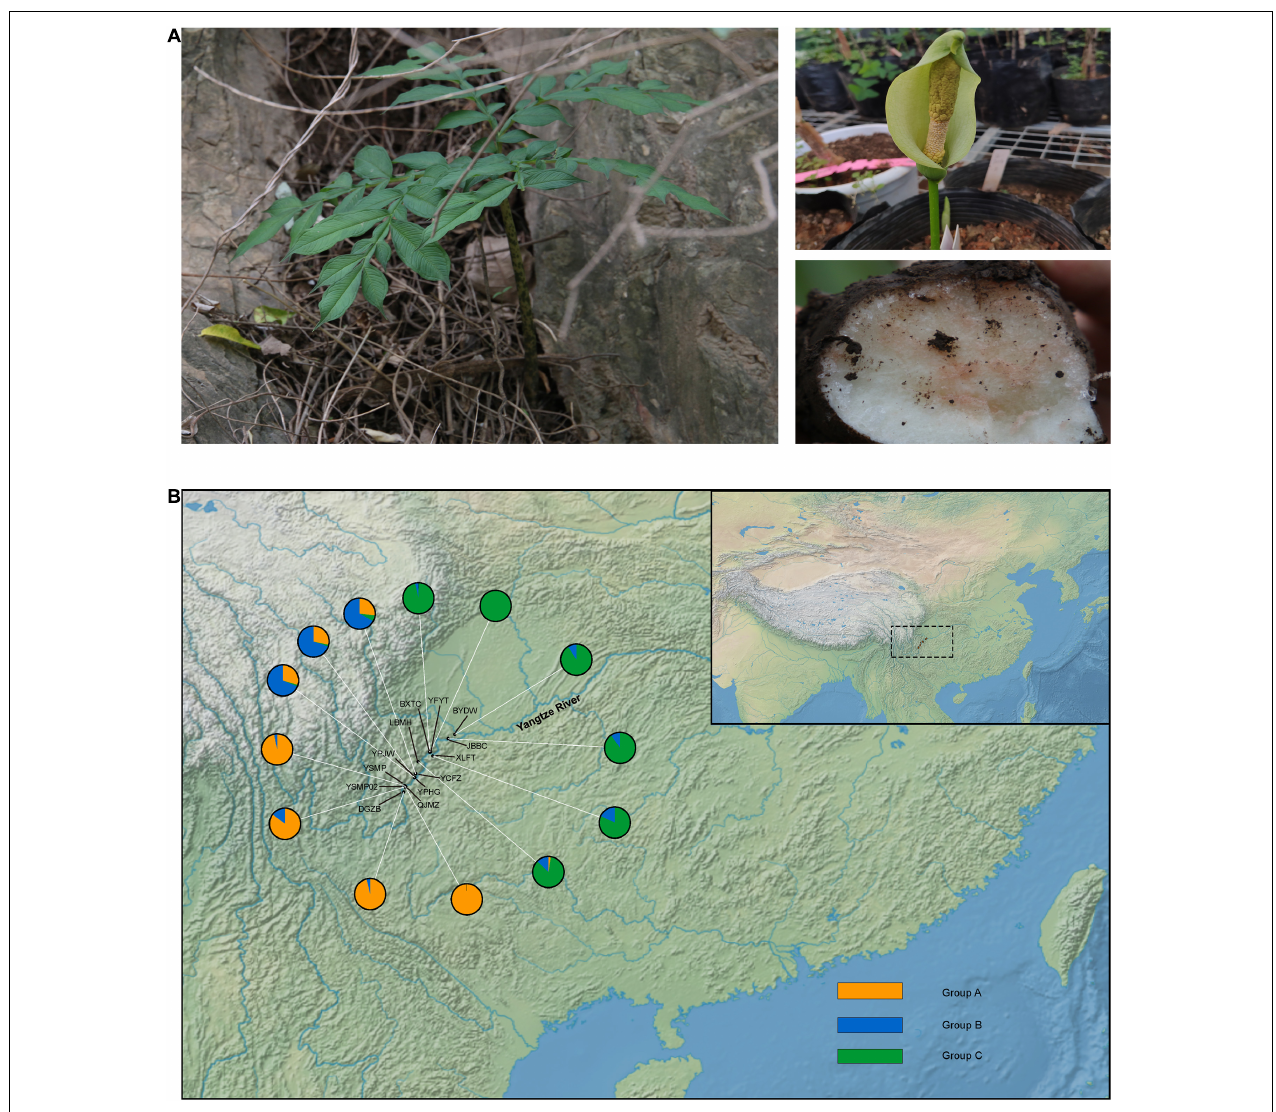
FIGURE 1 | Example and sampling sites of Amorphophallus albus . (A) The leaf, flower, and corm of Amorphophallus albus ; (B) map of the collection sites of Amorphophallus albus , individual pie charts indicate the membership proportions of each population for the inferred number of K = 3 by